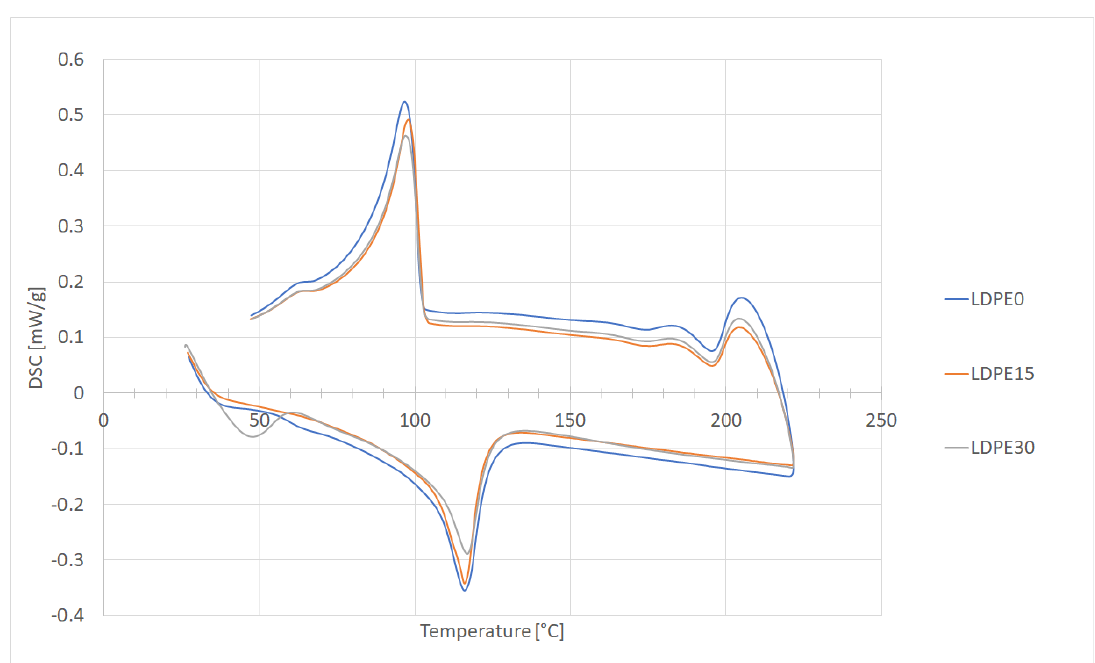
Figure 6. Differential scanning calorimetry (DSC) plots of neat LDPE and the obtained composites.